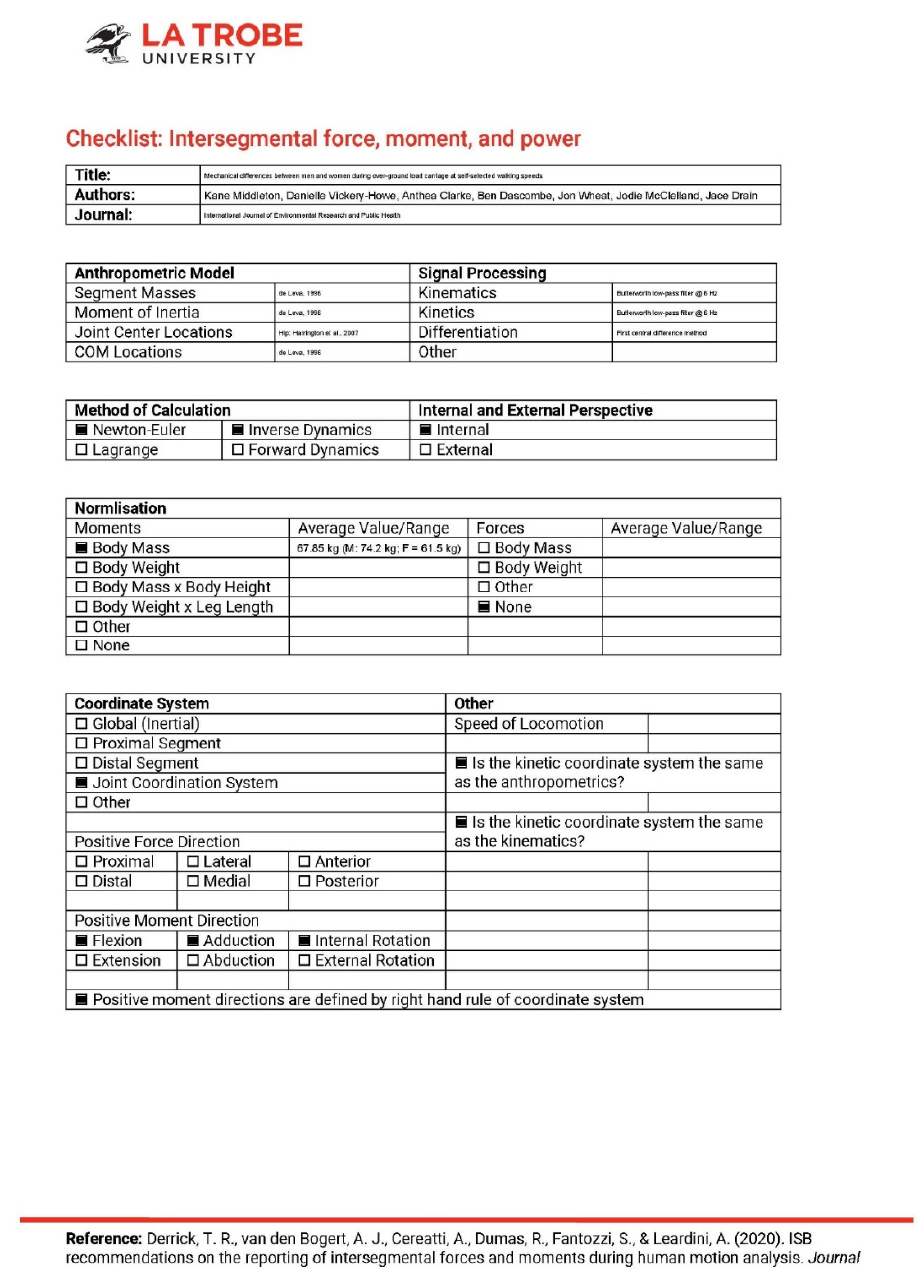
Figure A1. Checklist for the reporting of intersegmental moments.